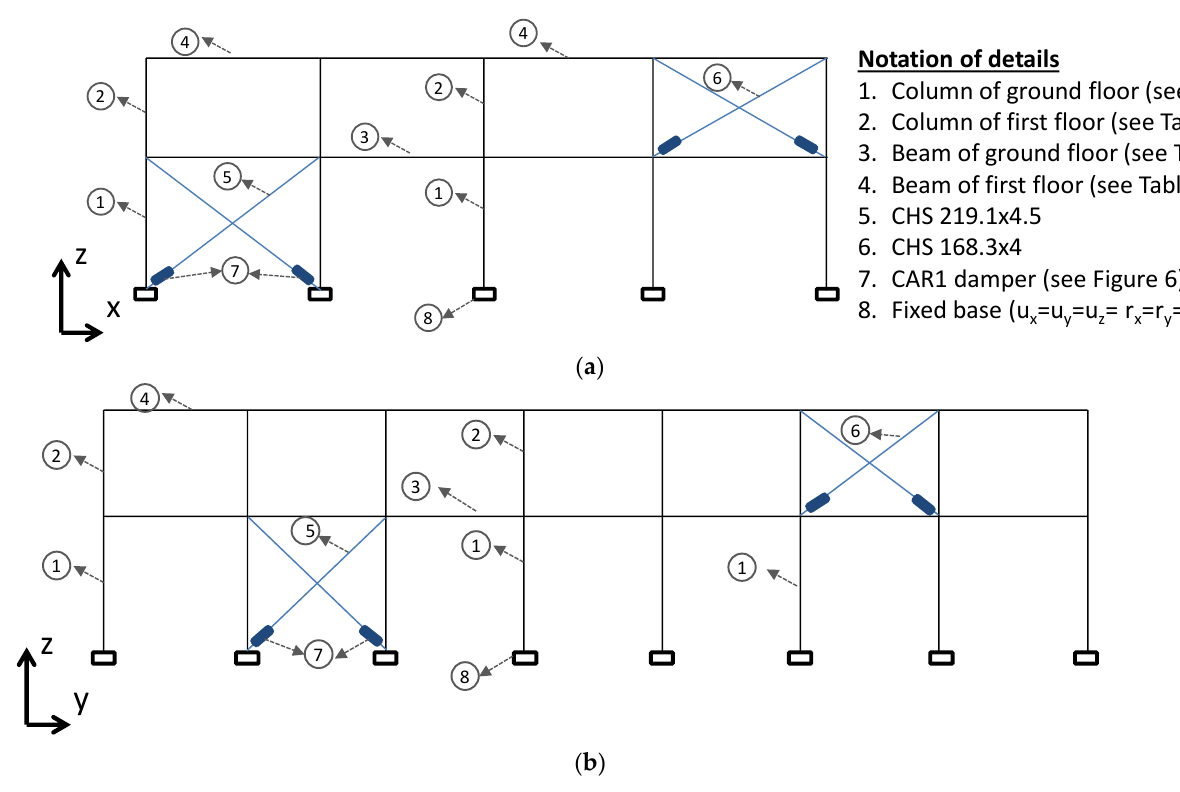
Figure 4. Redesign of building BM1 ( a ) x-x direction; ( b ) y-y direction.